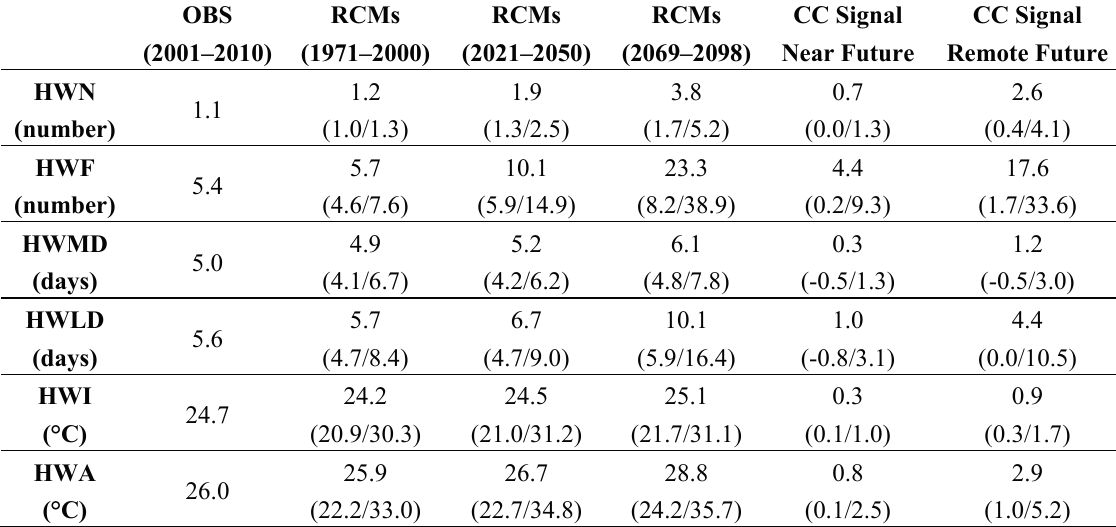
Table 2. Heat wave metrics averaged over Germany from observations (OBS, 2001–2010) and 19 regional model simulations for 1971–2000, 2021–2050, and 2069–2098. The last two columns specify the climate change (CC) signals for near and remote future climate (2021–2050 and 2069–2098, respectively, compared to 1971–2000). Regarding the simulations, for each period the ensemble mean (first number) as well as the minimum and the maximum ensemble member (in parentheses) are